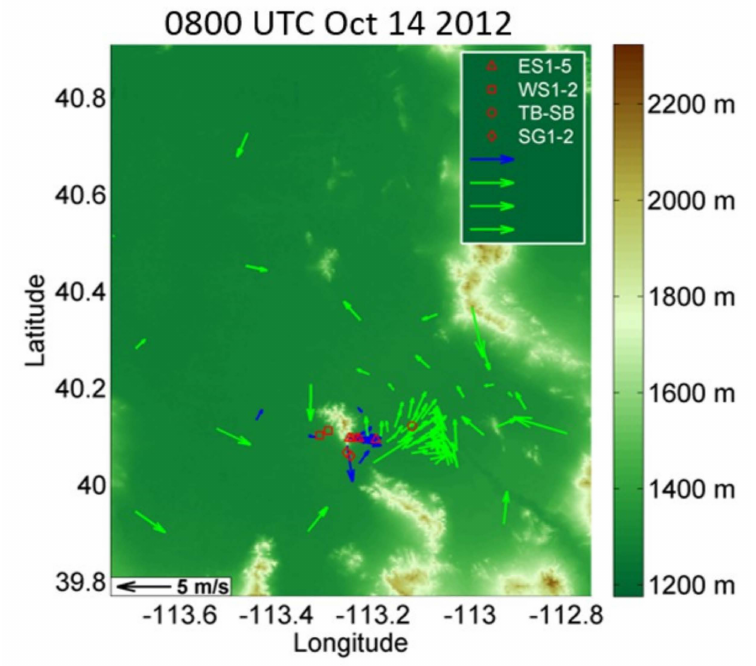
Figure 14. SAMS, mini-SAMS and other special MATERHORN 10 m AGL surface observations capturing flow over the GSL Playa, Granite Peak, and Dugway Valley at 0800 UTC